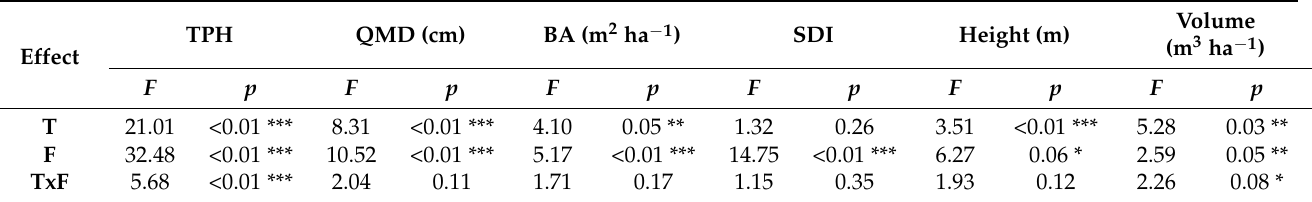
Table 3. Analysis of variance results for stand parameters at establishment (2019). Results include F -statistic ( F ) and p -values ( p ) of the measured effects of reclaimed water treatment (T) and facility (F) for stand parameters: TPH (Trees per hectare); QMD (Quadratic Mean Diameter); BA (Basal Area); SDI (Stand Density Index), Height and Volume.